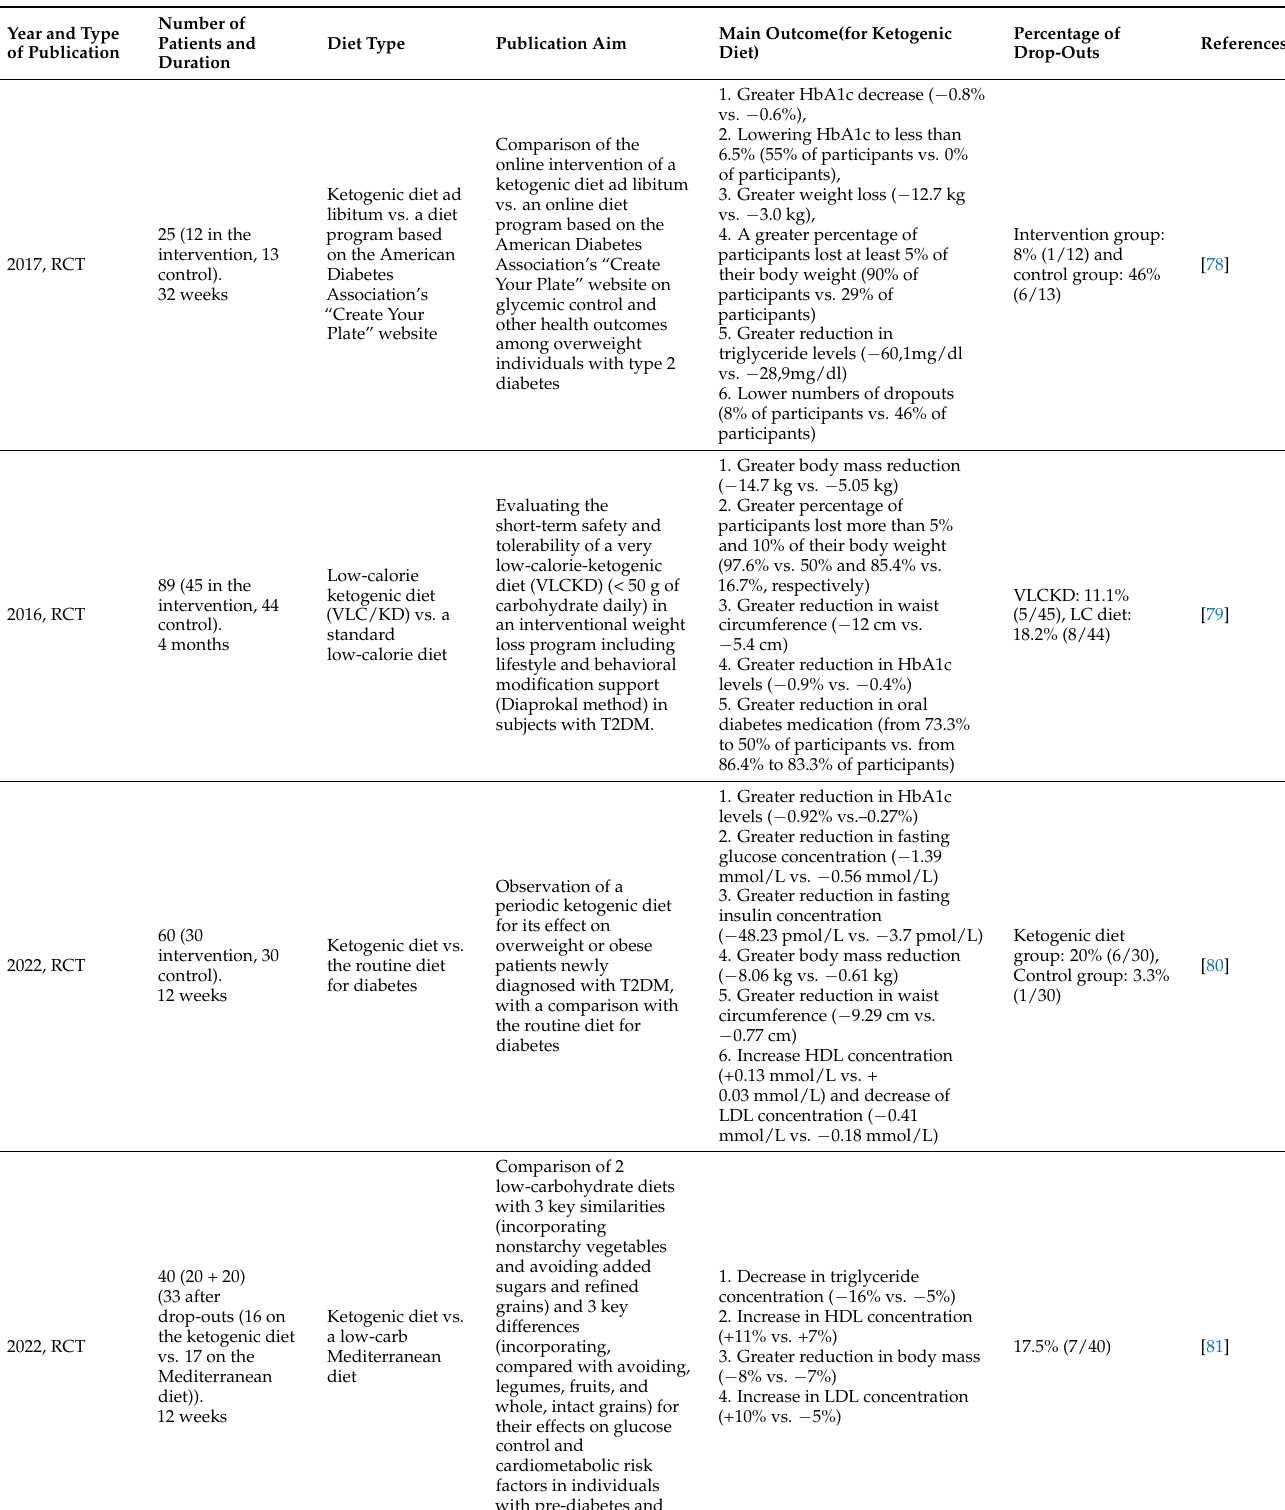
Table 4. Summary of the randomized controlled trials (RCT), listing the effect of a ketogenic diet on patients with type 2